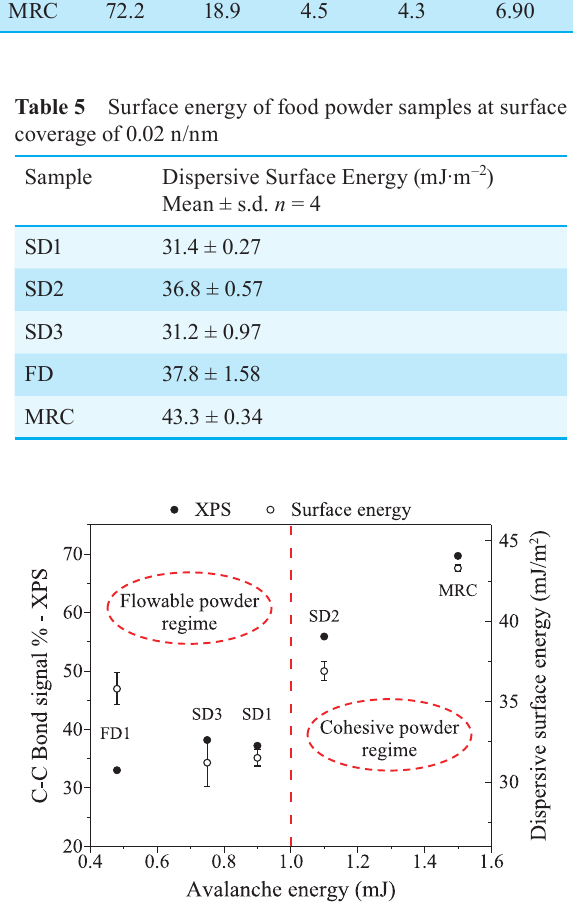
Fig. 5 Surface energy analysis at infinite dilution of starch modified with different enzymes and corresponding SEM microphotographs.